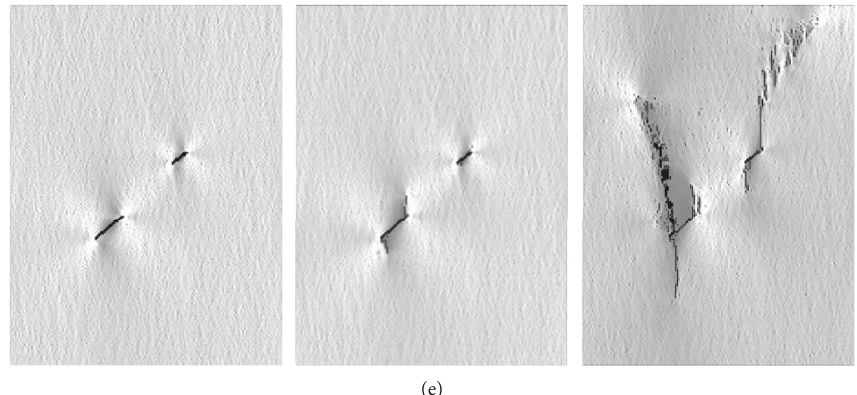
Figure 11: Simulation results of two unequal collinear cracks with varied bridge ligament ( a crack coalescence. (b) d � 10 mm, wing crack coalescence. (c) d � 20mm, shear-wing crack coalescence. (d) c � 30mm, wing crack failure. (e) d � 40mm, wing crack